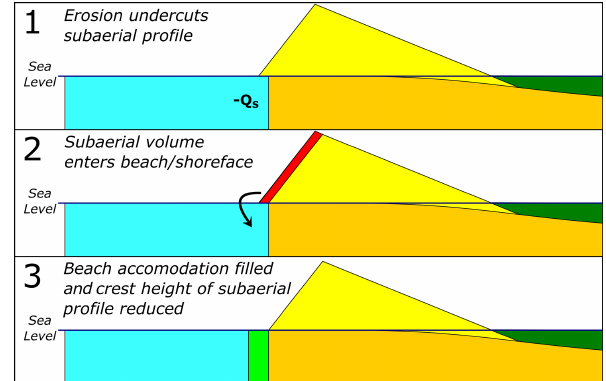
Figure 5. Conceptualization of erosion and redistribution of vol- ume in subaerial profile. As the shoreline erodes landward, the subaerial profile is undercut and scarped according to the sub- aerial front slope (cid:48) 1 . Scarped volume is transferred to the beach or shoreface and fills accommodation to extend the shoreline sea- ward as a function of volume divided by depth. Some of this sand volume may then be lost from the system through continued beach erosion. Yellow represents barrier sand, blue represents ocean, and dark green represents ,marsh. Q S stands for shoreface flux. Table 3. Inputs investigated for Subaerial Barrier Sediment Parti- tioning (SBSP)